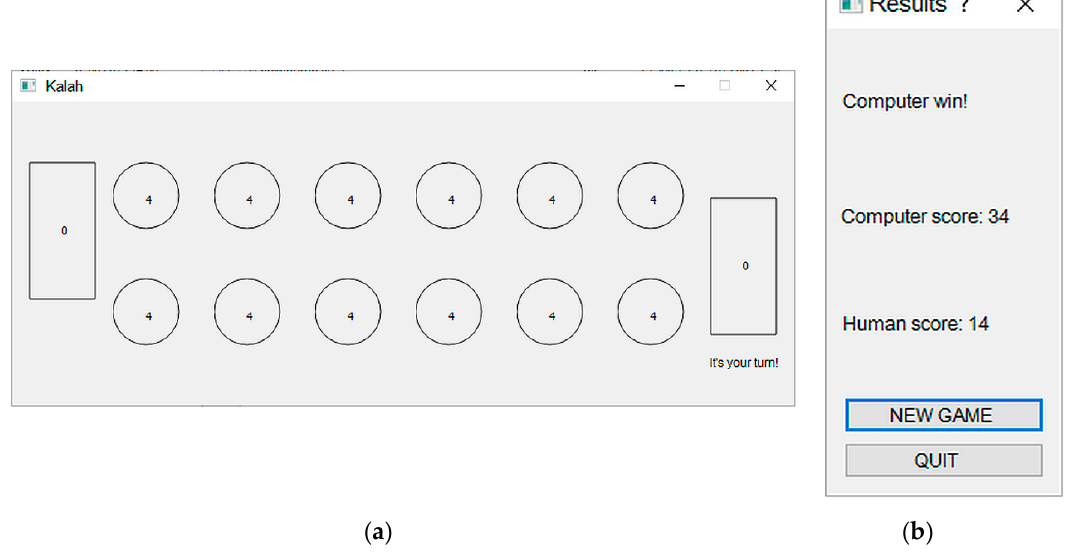
Figure 7. The main window ( a ) of the GUI and the window with game results ( b ).